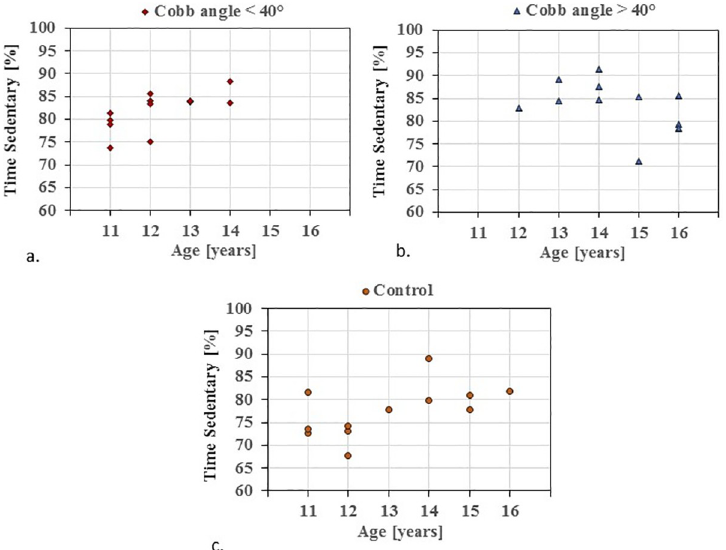
Fig 1. Individual data plot representing the average sedentary time (%) in relation to age in (a.) AIS Cobb angle < 40˚, (b.) AIS Cobb angle > 40˚and (c.) Controls.